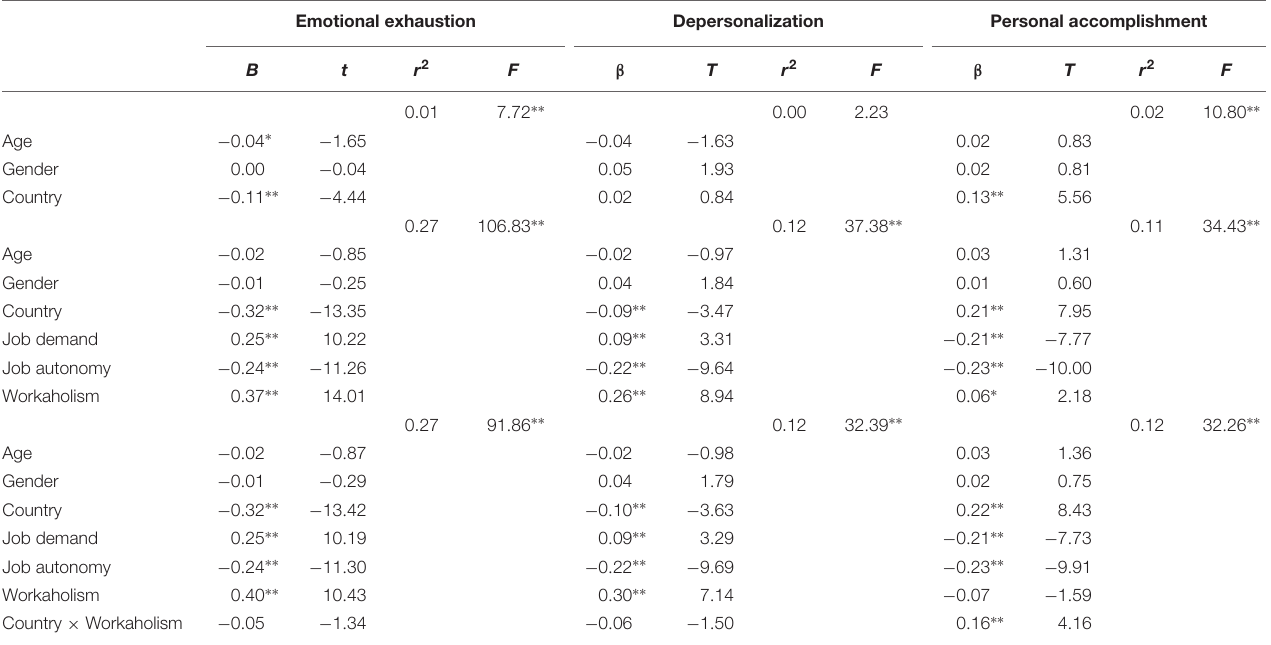
TABLE 8 | Moderated regression analysis for tertiary